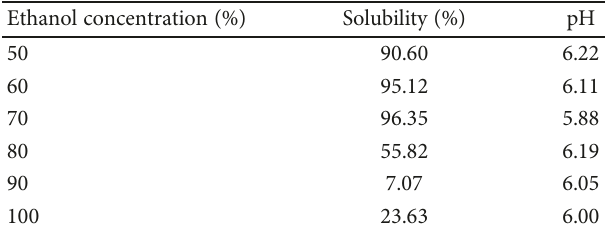
Table 2: E ff ect of the ethanol concentration on the solubility and pH of WGPSE